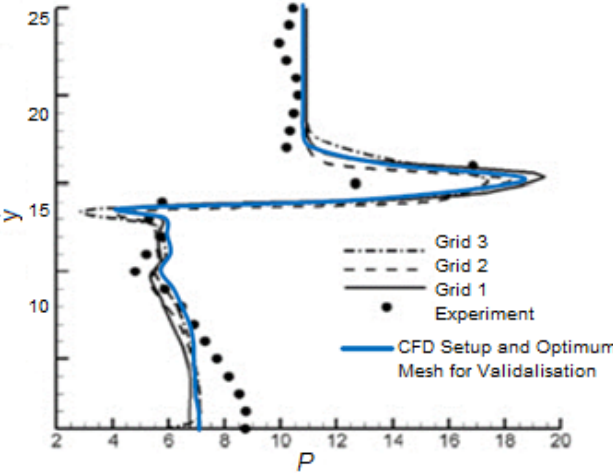
Figure 8. Comparison of pressure distribution in the nozzle.